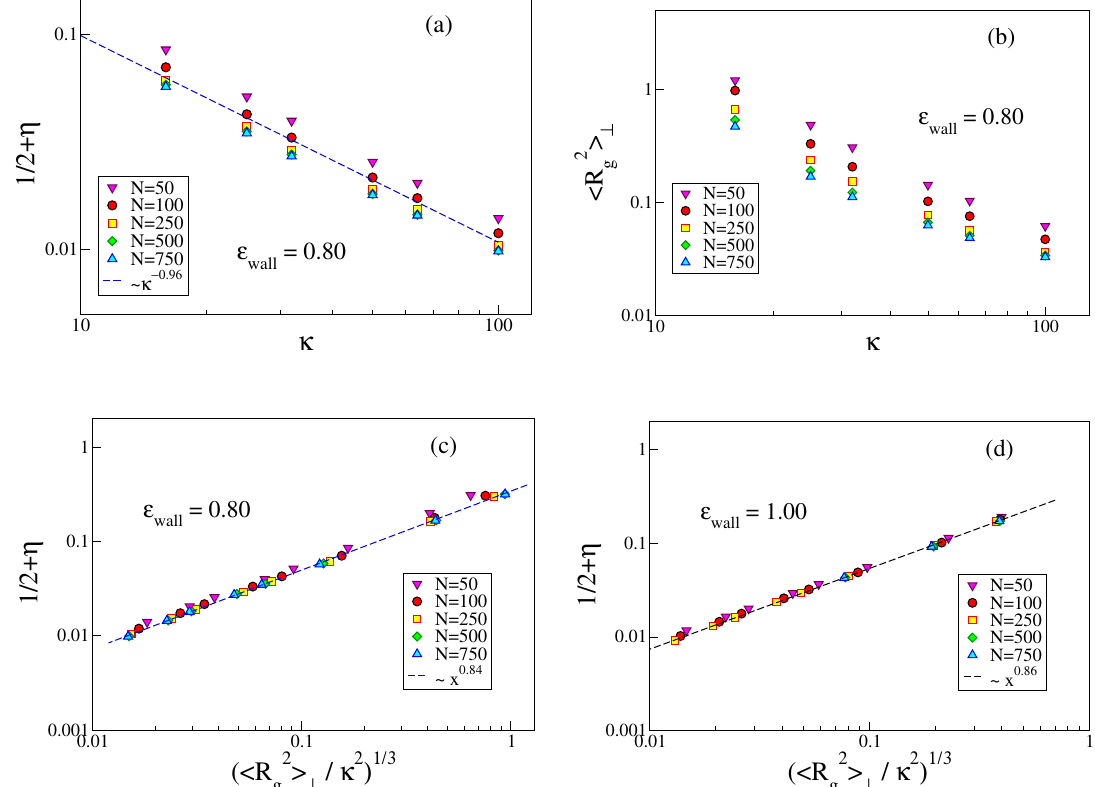
Figure 9. ( a ) log-log plot of 3/2 (cid:104) α 2 (cid:105) = 1/2 + η vs. stiffness κ at (cid:101) wall = 0.80 for several choices of N , as indicated. Only data for κ ≥ 16 are included so as to restrict attention to the strongly adsorbed case; ( b ) the same as ( a ), but for (cid:104) R 2 g (cid:105) ⊥ vs. κ ; ( c ) log-log plot of 1/2 + η vs. ( d ) the same as in ( c ), but for (cid:101) wall =